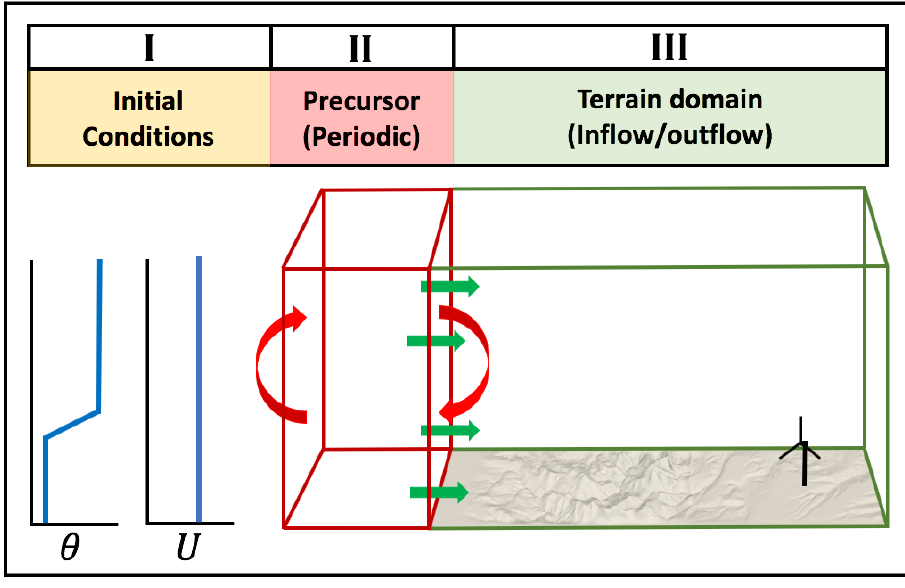
Figure 1. A simple schematic depicting the initial conditions, the periodic precursor setup, and the terrain